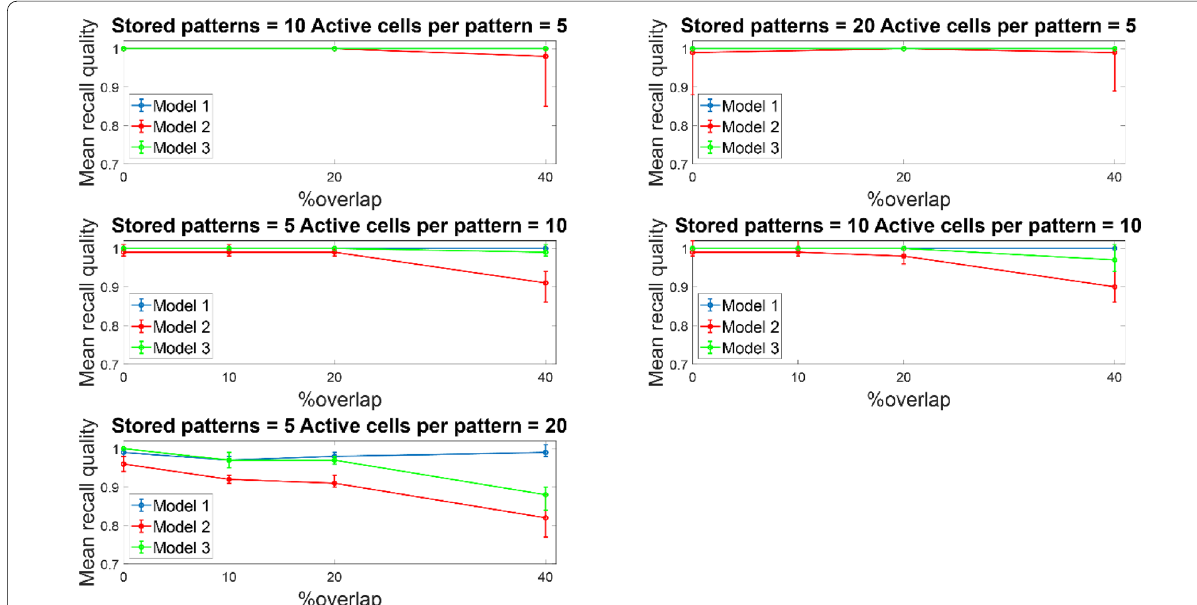
Fig. 8 Mean recall quality of ‘model 1’, ‘model 2’, and ‘model 3’ as a function of percent overlap (0%, 10%, 20%, 40%). Each model was a network of 300 PCs, 1 BSC, and 1 OLM cell